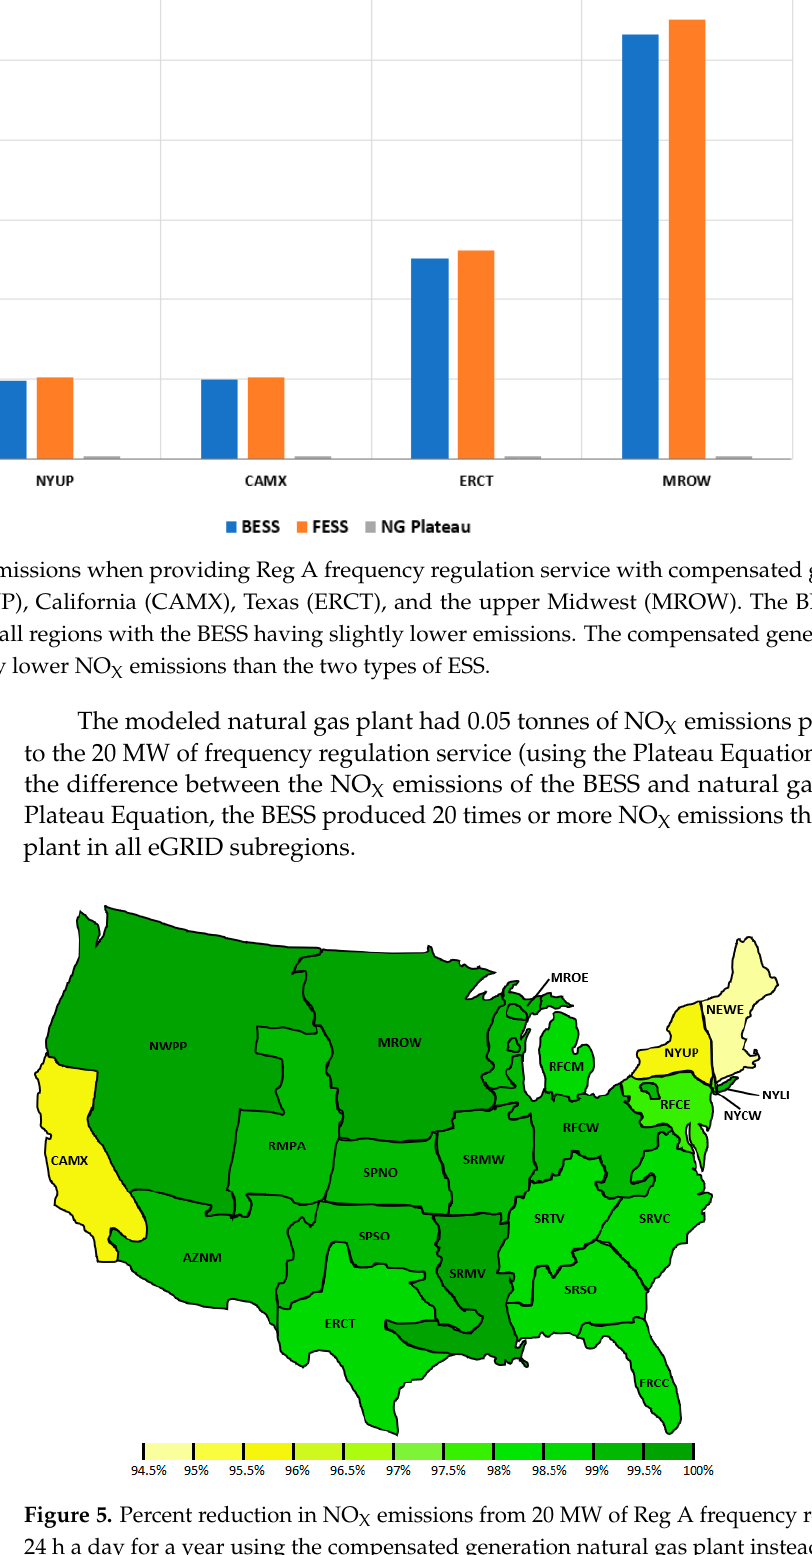
Figure 5. Percent reduction in NO X emissions from 20 MW of Reg A frequency regulation operating 24 h a day for a year using the compensated generation natural gas plant instead of the BESS.